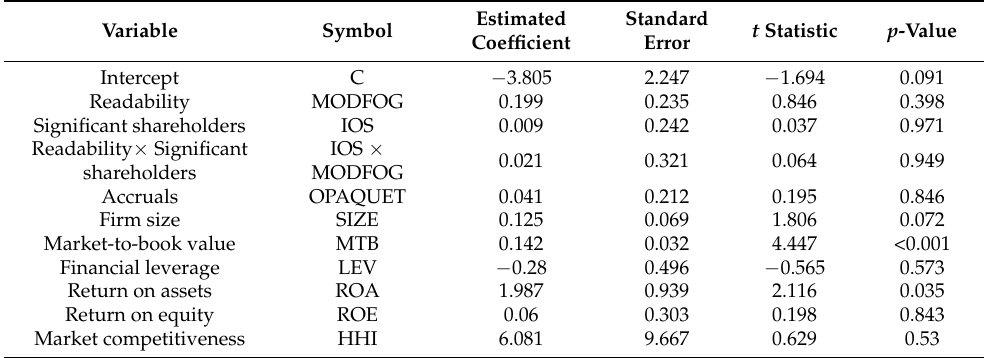
Table 12. Sensitivity analysis of the third